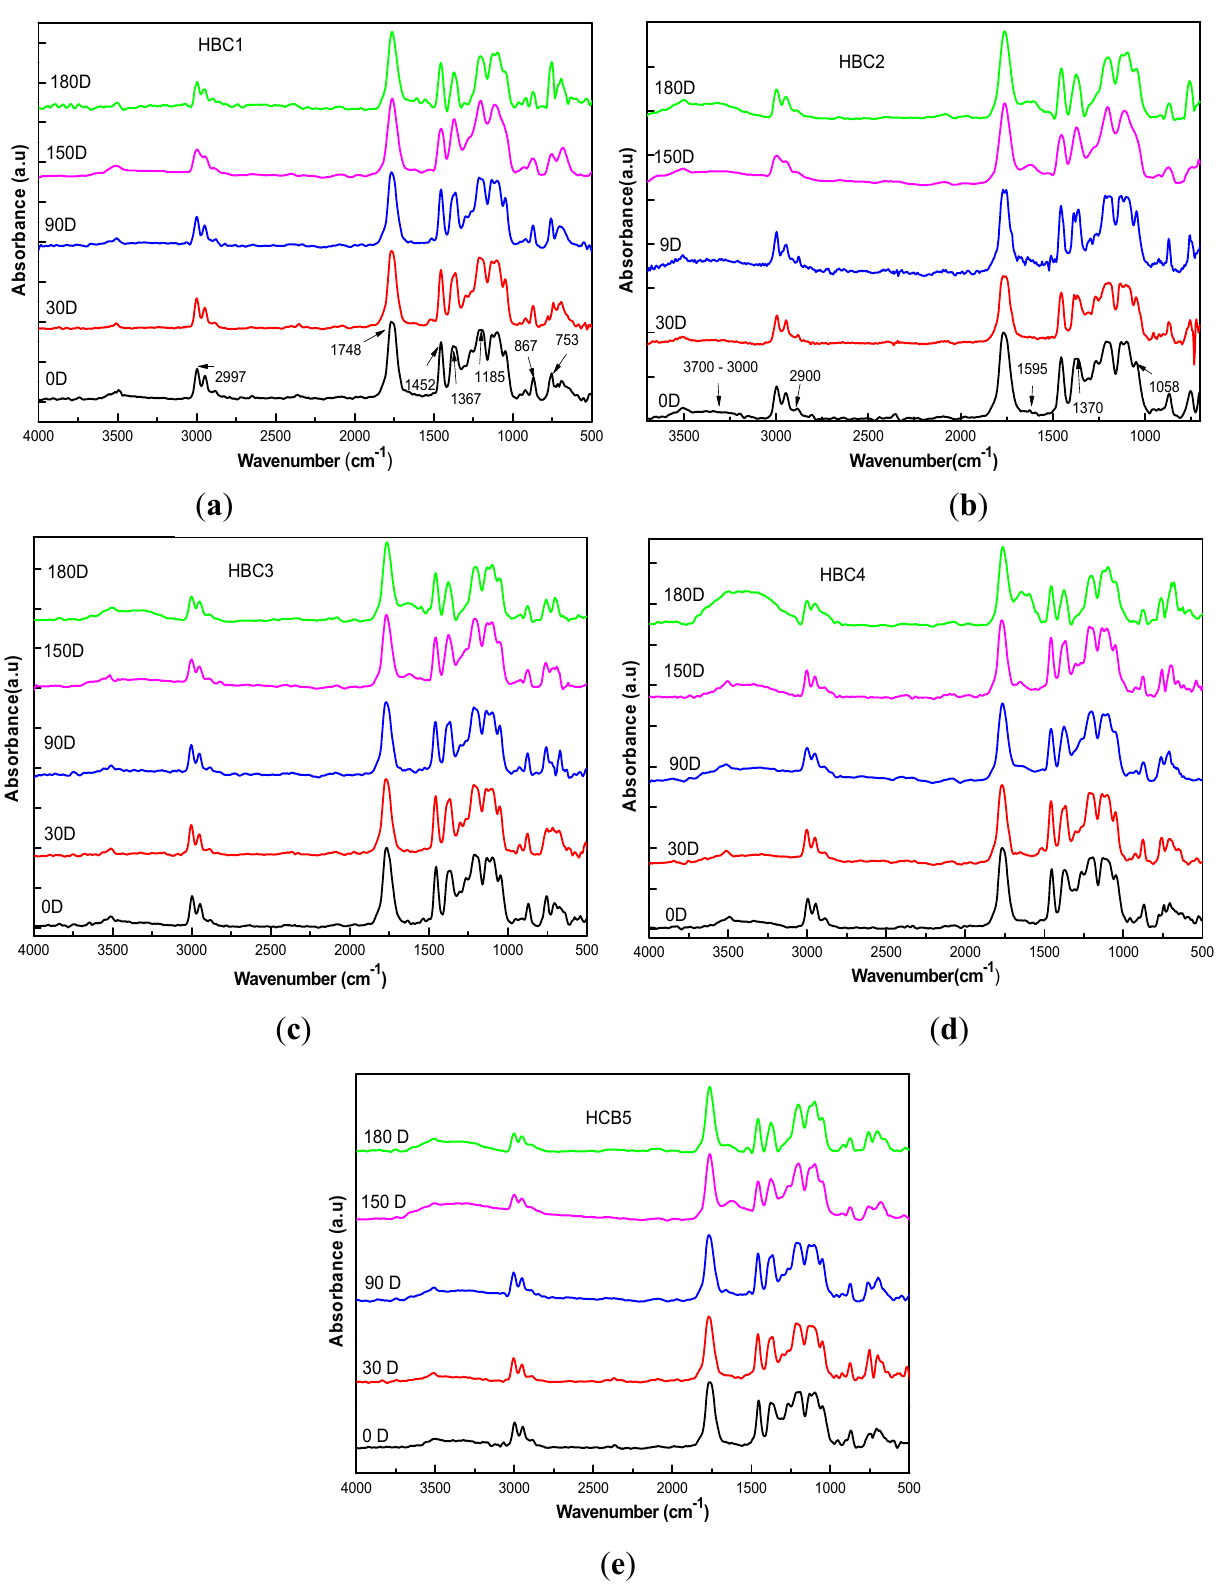
Figure 6. HBC infrared spectra for different composting days in samples: ( a ) HBC1; ( b ) HBC2; ( c ) HBC3; ( d ) HBC4; ( e ) HBC5.